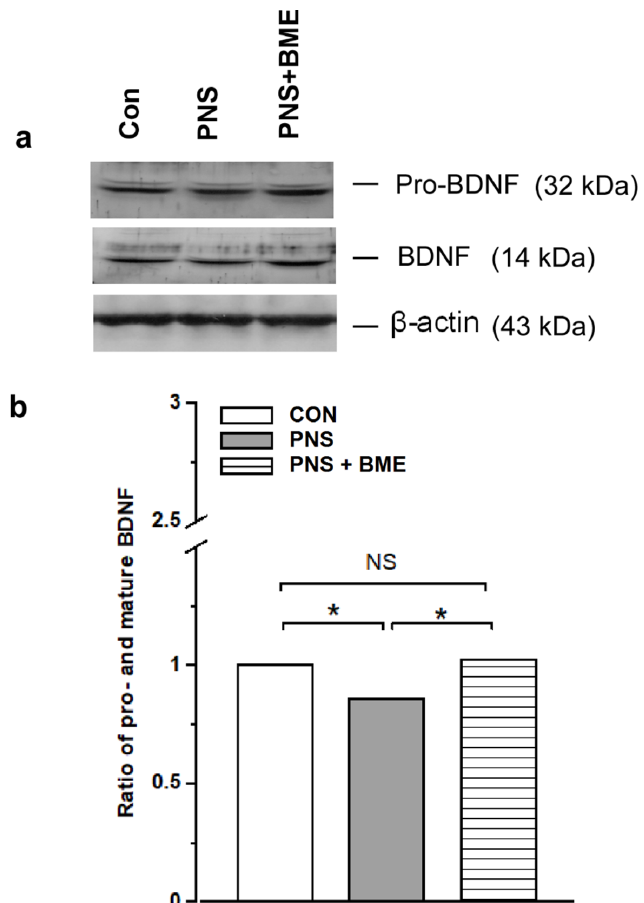
Figure 12. Effect of exposure to BME treatment on pro and mature brain-derived neurotrophic factor (BDNF) in PNS offspring. ( a ) Representative Western blots depicting the level of pro BDNF and mature BDNF; ( b ) Exposure to BME treatment silences the PNS-induced changes in the ratio of proand mature BDNF. Data are expressed as mean ± SEM ( n = 6 / each group). One-way ANOVA followed by Bonferroni post hoc test (for all pairwise multiple comparisons, statistical significance is indicated by * p < 0.05; NS—Not significant).